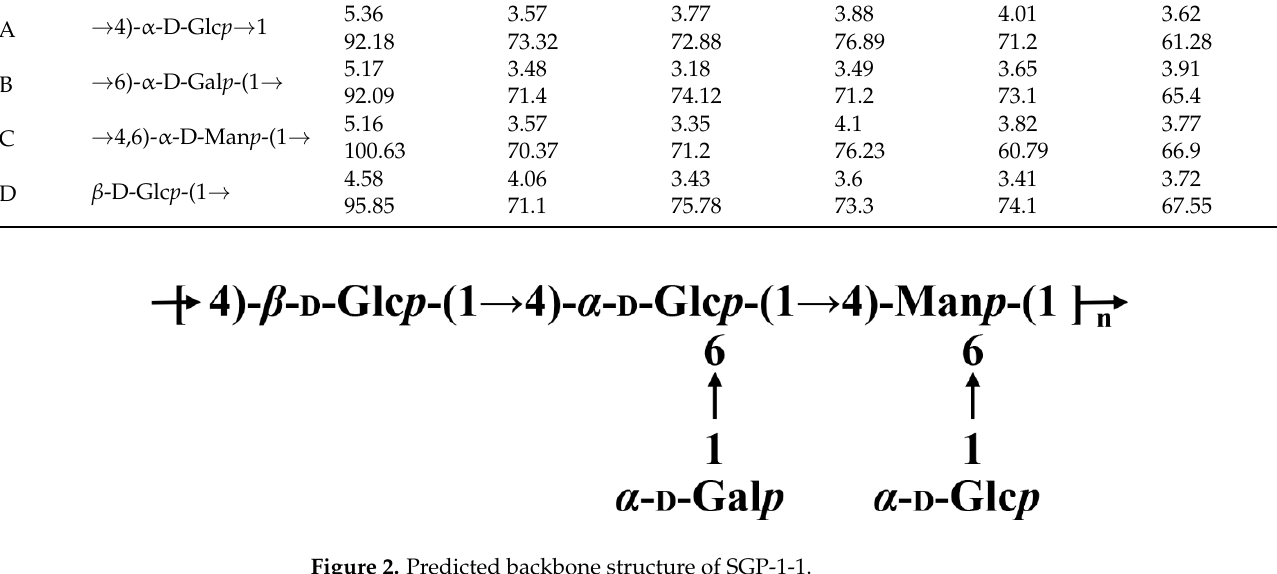
Figure 2. Predicted backbone structure of SGP-1-1 .